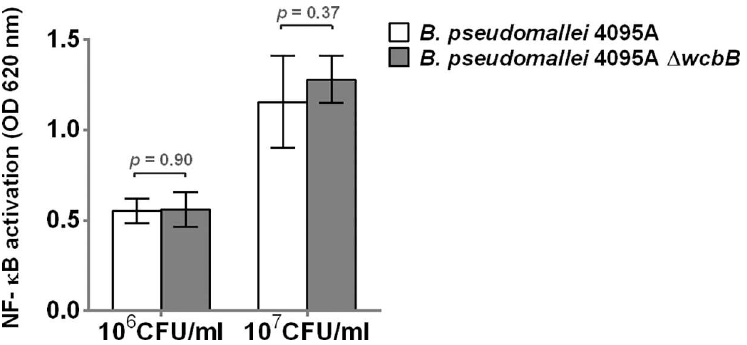
Fig 10. Activation of NF- κ B in HEK-Blue hTLR4 cells by heat-killed wild type 4095A and mutant containing unmarked deletions of wcbB . The HEK-Blue hTLR4 cells were stimulated with heat-killed bacteria at 10 6 or 10 7 CFU/ml at 37˚C in 5% CO 2 for 24 h. NF- κ B activation was determined in the supernatant by a SEAP reporter assay. Mean ± SD of two independent experiments were illustrated.